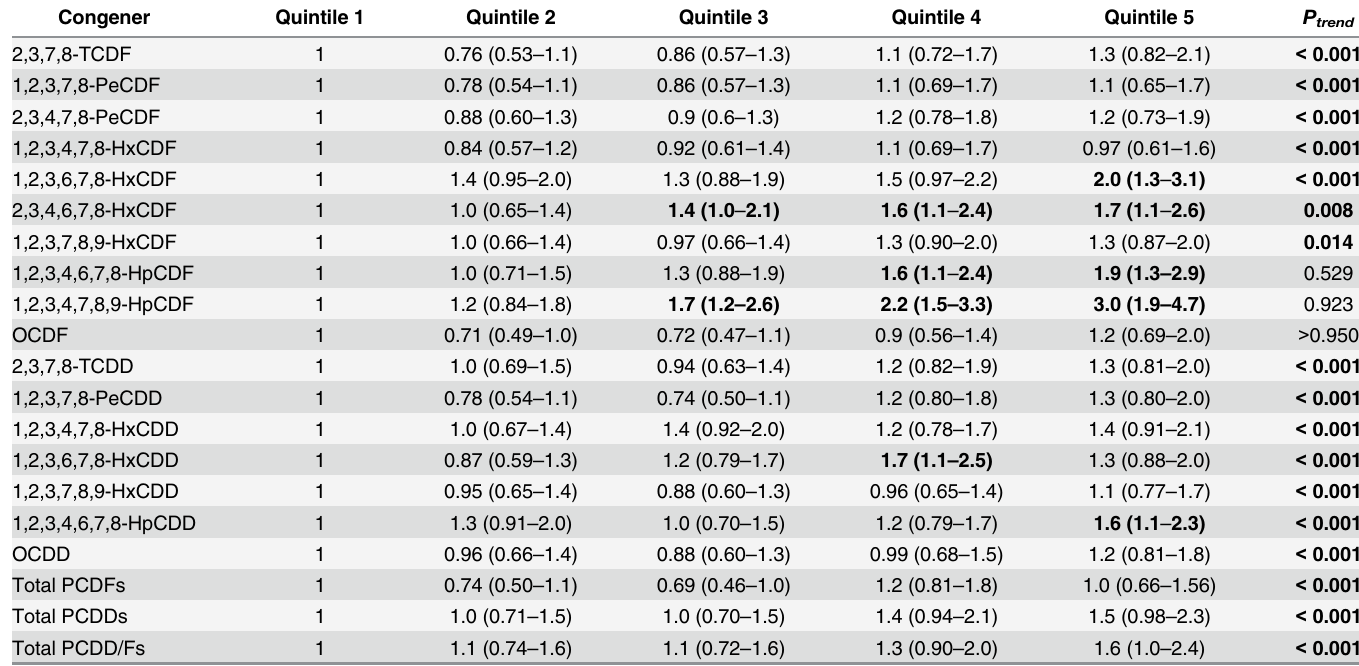
Table 4. Adjusted ORs (95% CIs) of the prevalence of abdominal obesity by quintiles of the concentrations of the selected congeners